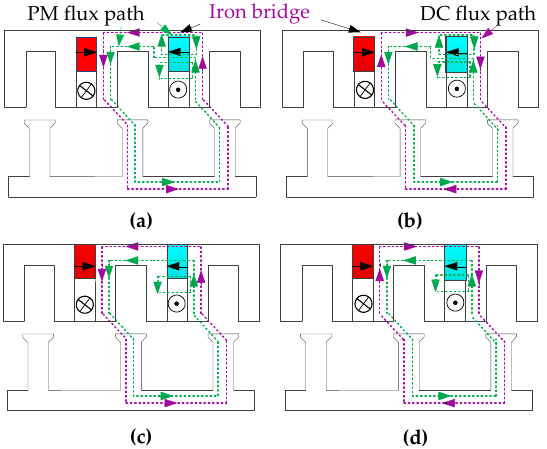
Figure 3 . Operation principle of HEFS machine. ( a ) Flux enhancing, with iron bridges; ( b ) Flux weakening, with iron bridges; ( c ) Flux enhancing, without iron bridges; ( d ) Flux weakening, without iron bridges.